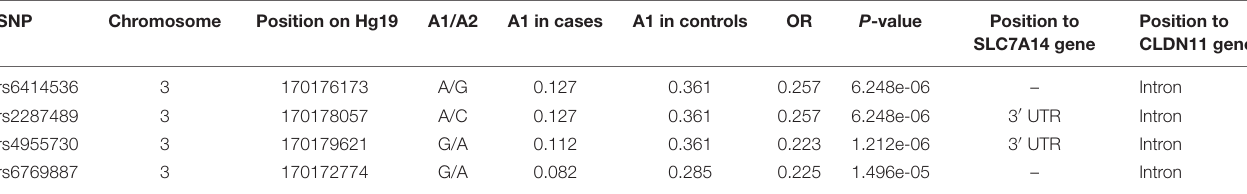
Figure 1. No SNPs were significantly associated with SaIE at the genome-wide level ( p -value < 5 × 10 − 8 ). Four “suggestive” SNPs ( p -value < 1 × 10 − 5 ) were located on one locus on chromosome 3, near the genes CLDN11 and SLC7A14 ( Figure 3 ). Table 2 shows the minor allele frequencies for cases and controls for these four three SNPs as well as odd ratios. For these four SNPs, the frequency of the minor allele was lower in cases than in controls, suggesting a protective effect of the minor allele against SaIE. The top three associated SNPs (rs6414536, rs2287489, and rs4955730) are in high LD ( r 2 > 0.88). The fourth SNP (rs6769887) located close to the top 3 associated SNPs and in moderate LD ( r 2 > 0.56) had a p -value of 1.5 × 10 − 5 . A LD plot for all SNPs located near ( ± 10 kb) rs2287489 and rs6414536 is presented in Figure 4